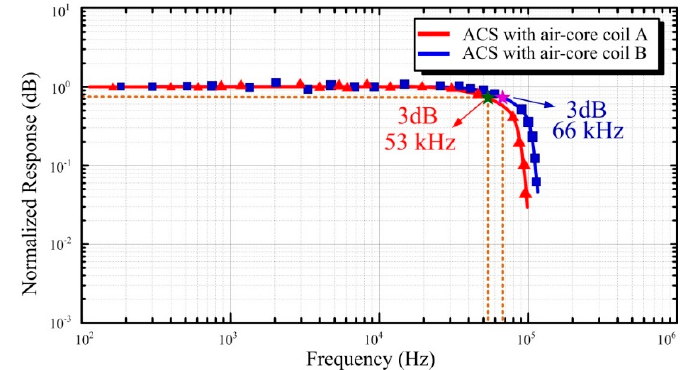
Figure 12. 3 dB bandwidth of the two ACSs.